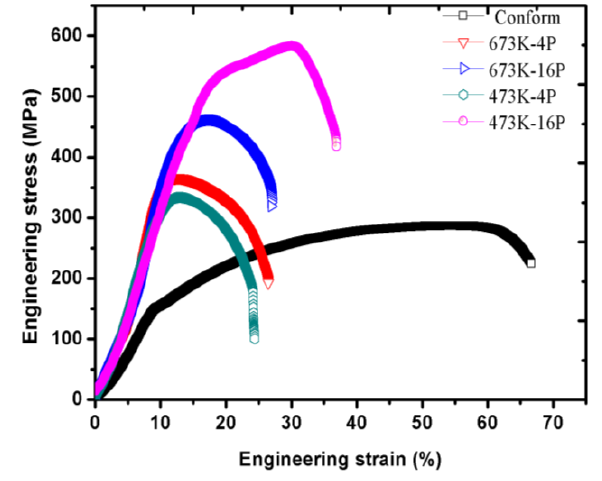
Figure 6. Stress-strain tensile curves of the samples subjected to various passes ECAP at 437 K and 673